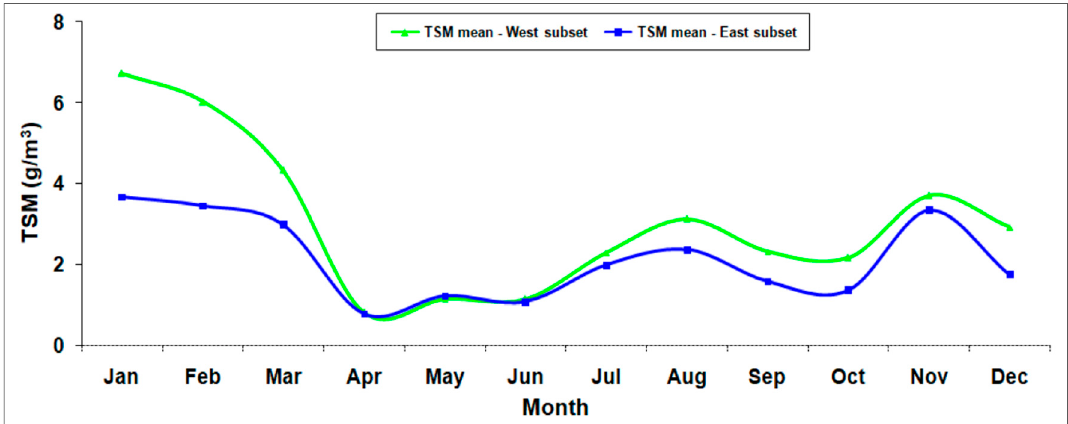
Figure 11. The 2014–2018 TSM seasonal cycles spatially averaged over the West and East subsets, depicted by continuous green and blue lines, respectively.